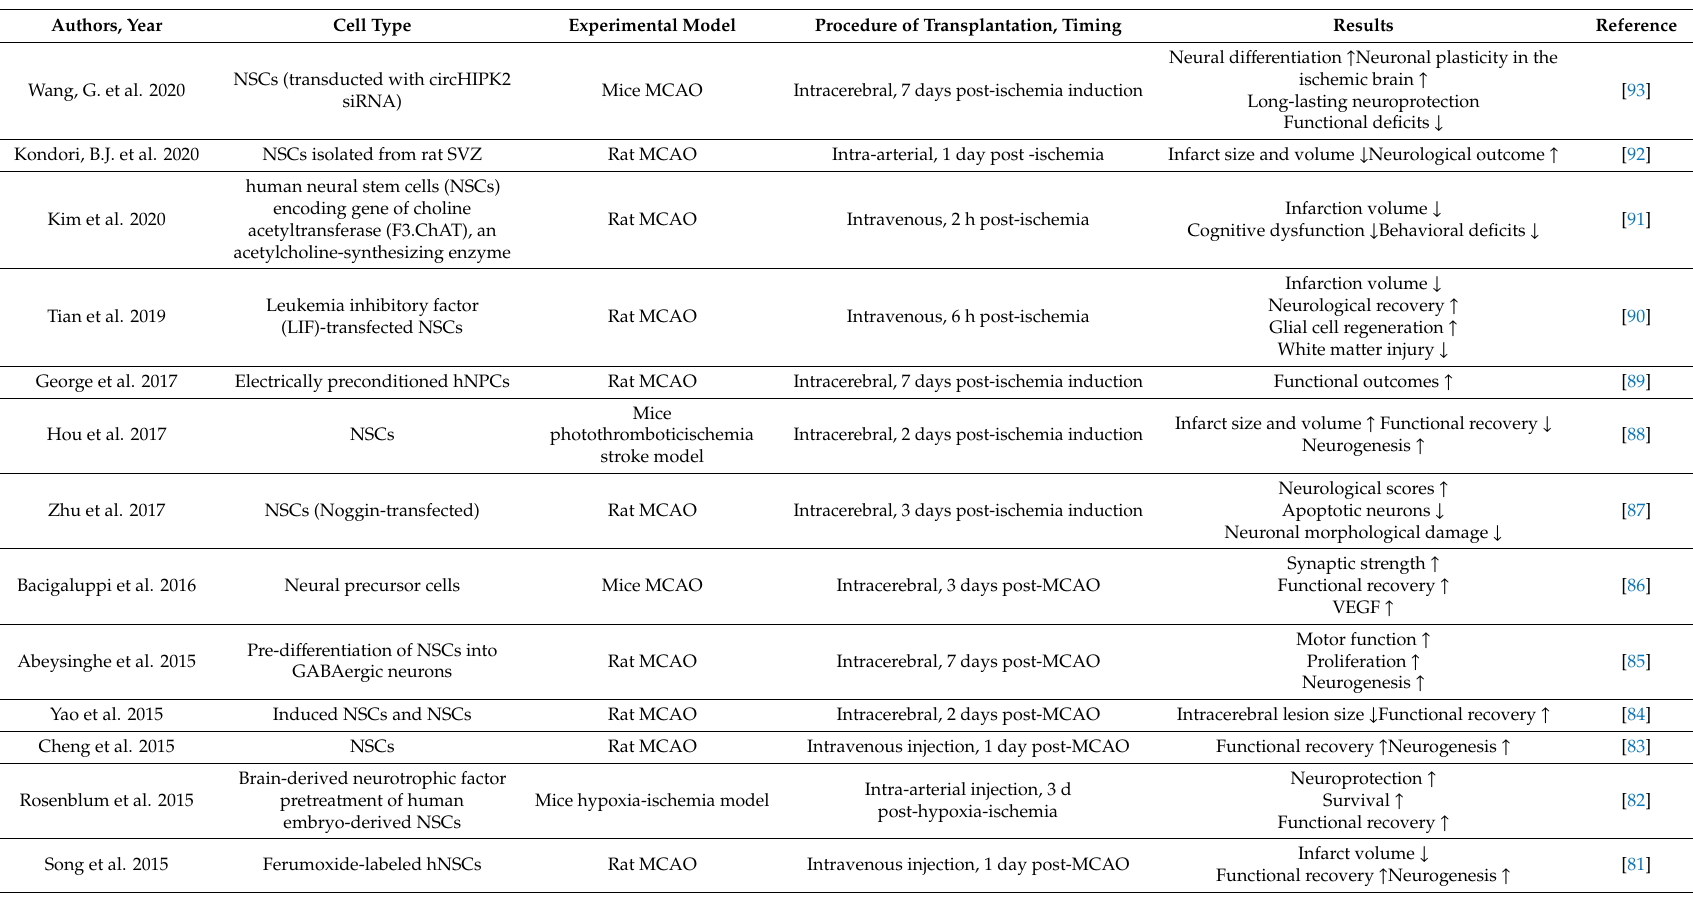
Table 4. Experimental study for the neural stem cells (NSCs) transplantation into ischemic brain injury in animal